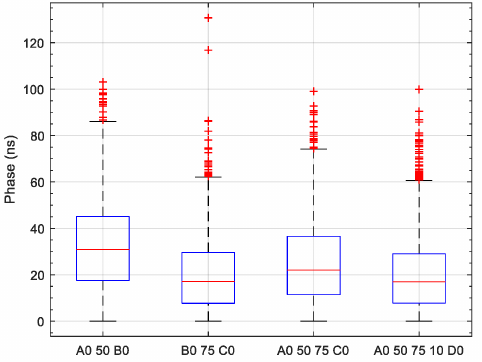
Figure 21. Box diagram for SAR with an